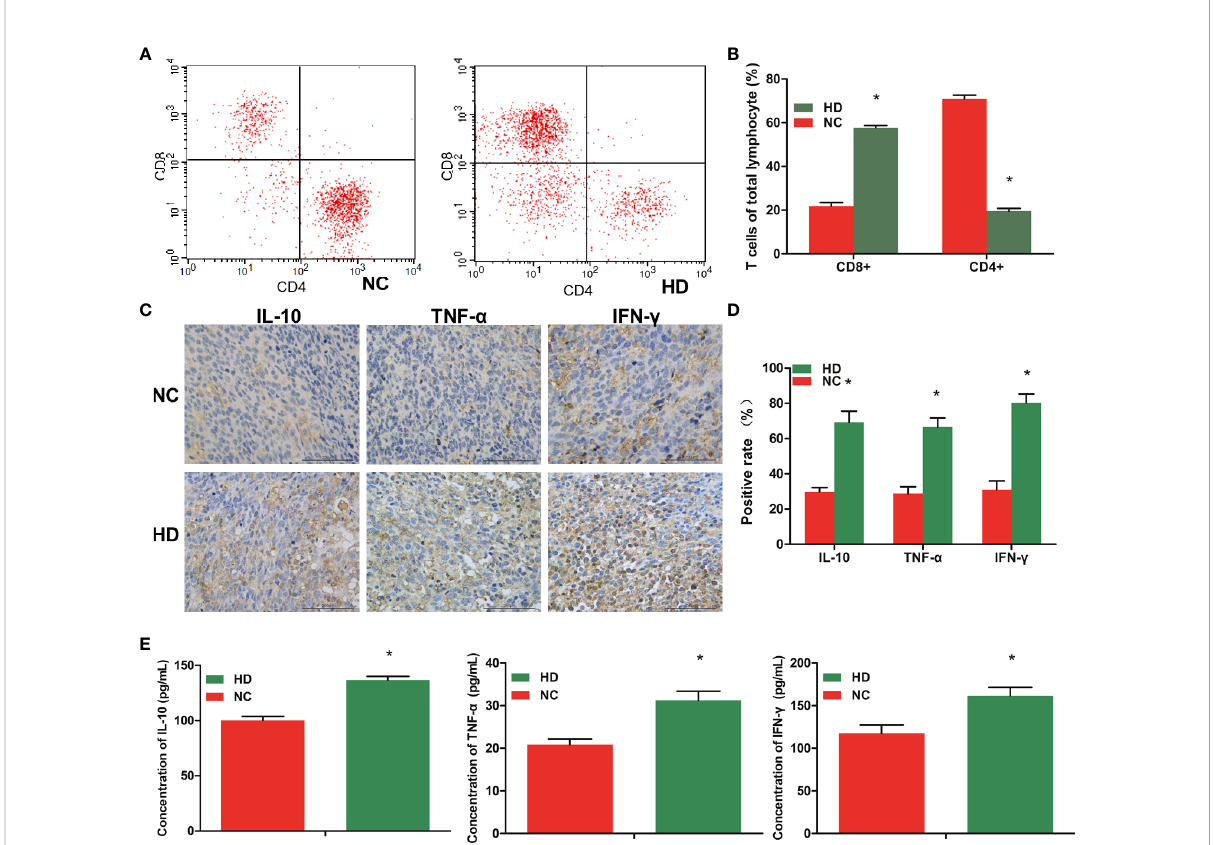
FIGURE 5 WJR treatment enhances anti-tumor immunity. (A, B) Flow cytometry was used to analyze the proportion of CD8 + T-cell and CD4+T cell in the total peripheral blood lymphocyte cells. (C, D) The expression levels of IL-10, IFN- g , and TNF- a in the tumor tissue was analyzed by immunohistochemistry. (E) The expression levels of IL-10, IFN- g , and TNF- a in serum was analyzed by ELISA. (n = 4). WJR, Wenzi Jiedu Recipe; NC, control group; HD, high-dose group of WJR. *vs. NC, p <